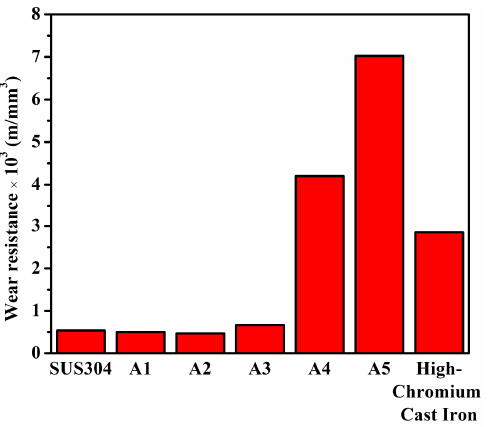
Figure 4. Wear resistance of A1, A2, A3, A4, and A5, SUS304 stainless steel, and high-chromium cast iron.